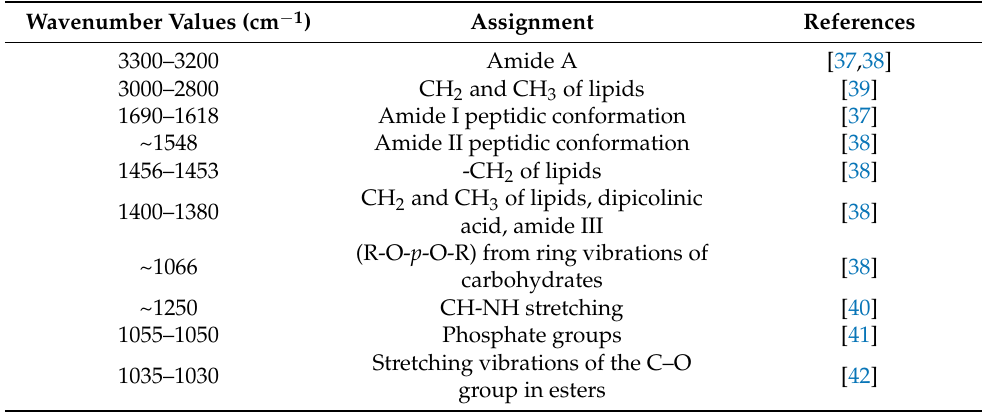
Table 5. FTIR band assignments for the functional groups.